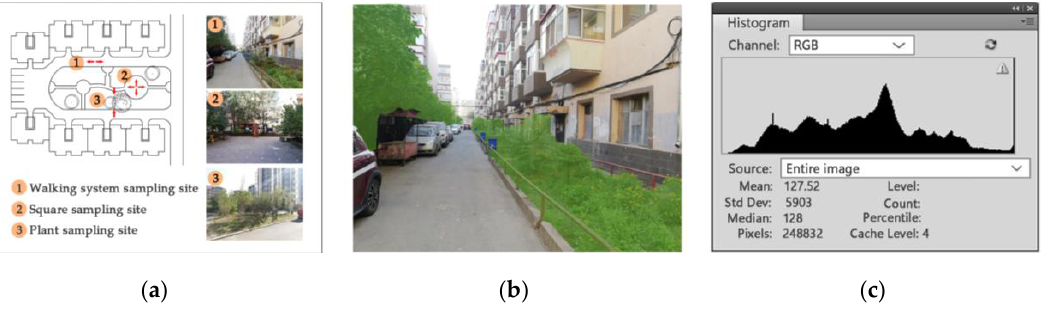
Figure 1. Measurement of the Green View Index. ( a ) Sample site setting and image collection in the field study; ( b ) green area extraction from images using an artificial visual interpretation method in Adobe Photoshop; ( c ) the Green Vison Index calculation based on Adobe Photoshop (source: combining the method of reference [35,51 – 53] with the images of neighbourhoods in the field